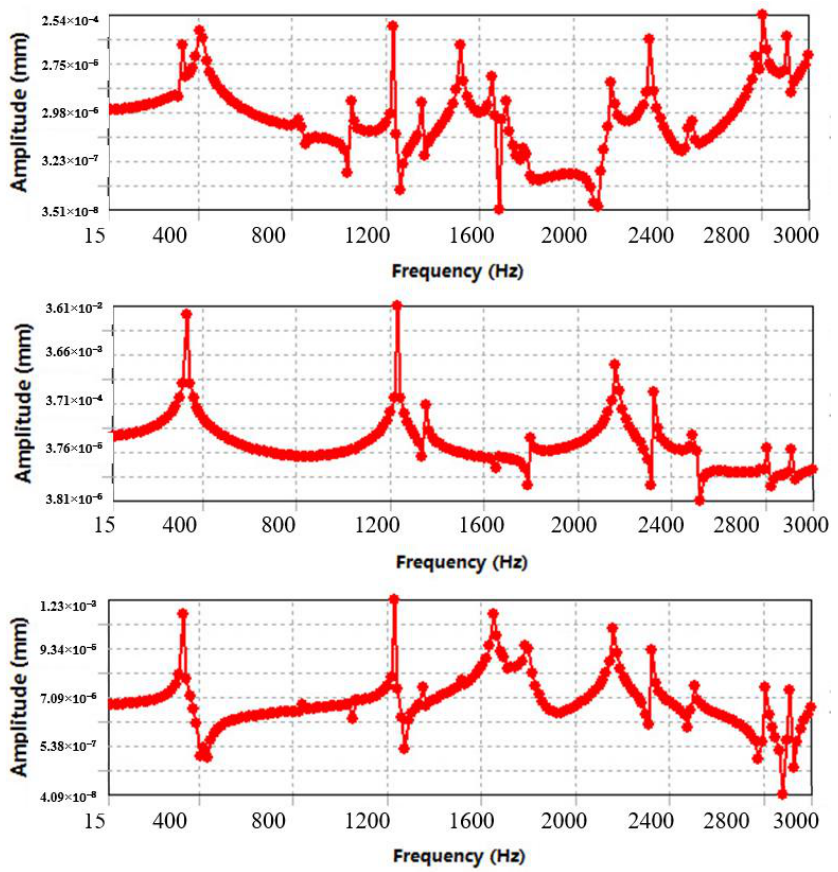
Figure 15. Harmonic response in X/Y/Z direction at upper limit of separate structure.